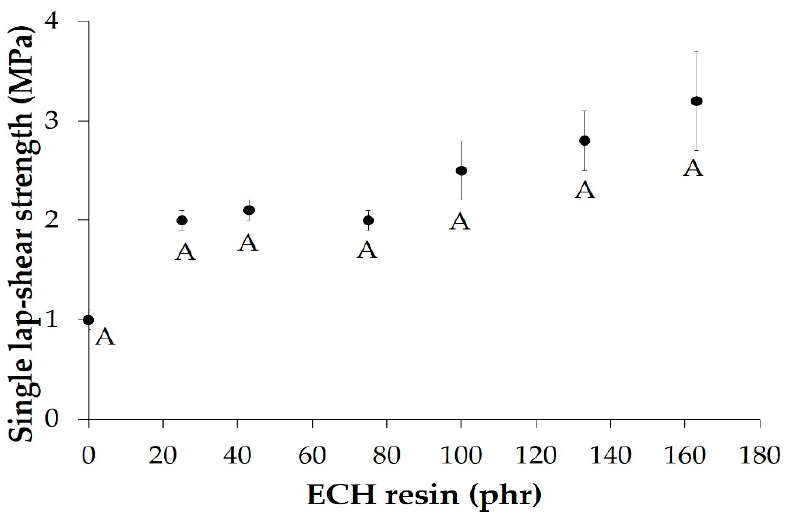
Figure 16. Variation of the single lap-shear strength of aluminum/EBA copolymer + ECH resin blend/aluminum joints as a function of the amount of ECH in the binary blend. Locus of failure: A: Adhesive failure.